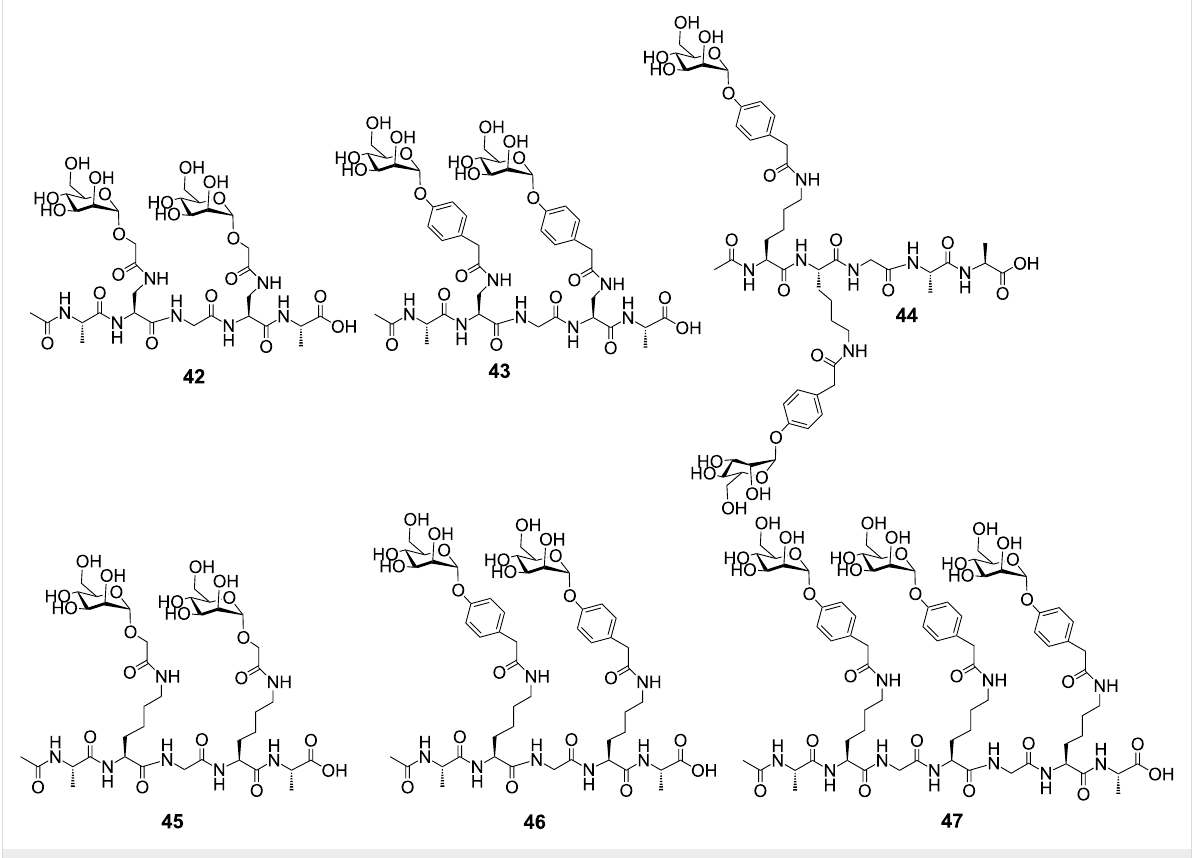
Figure 2: Di- and trivalent glycopeptide dendrimers evaluated for FimH